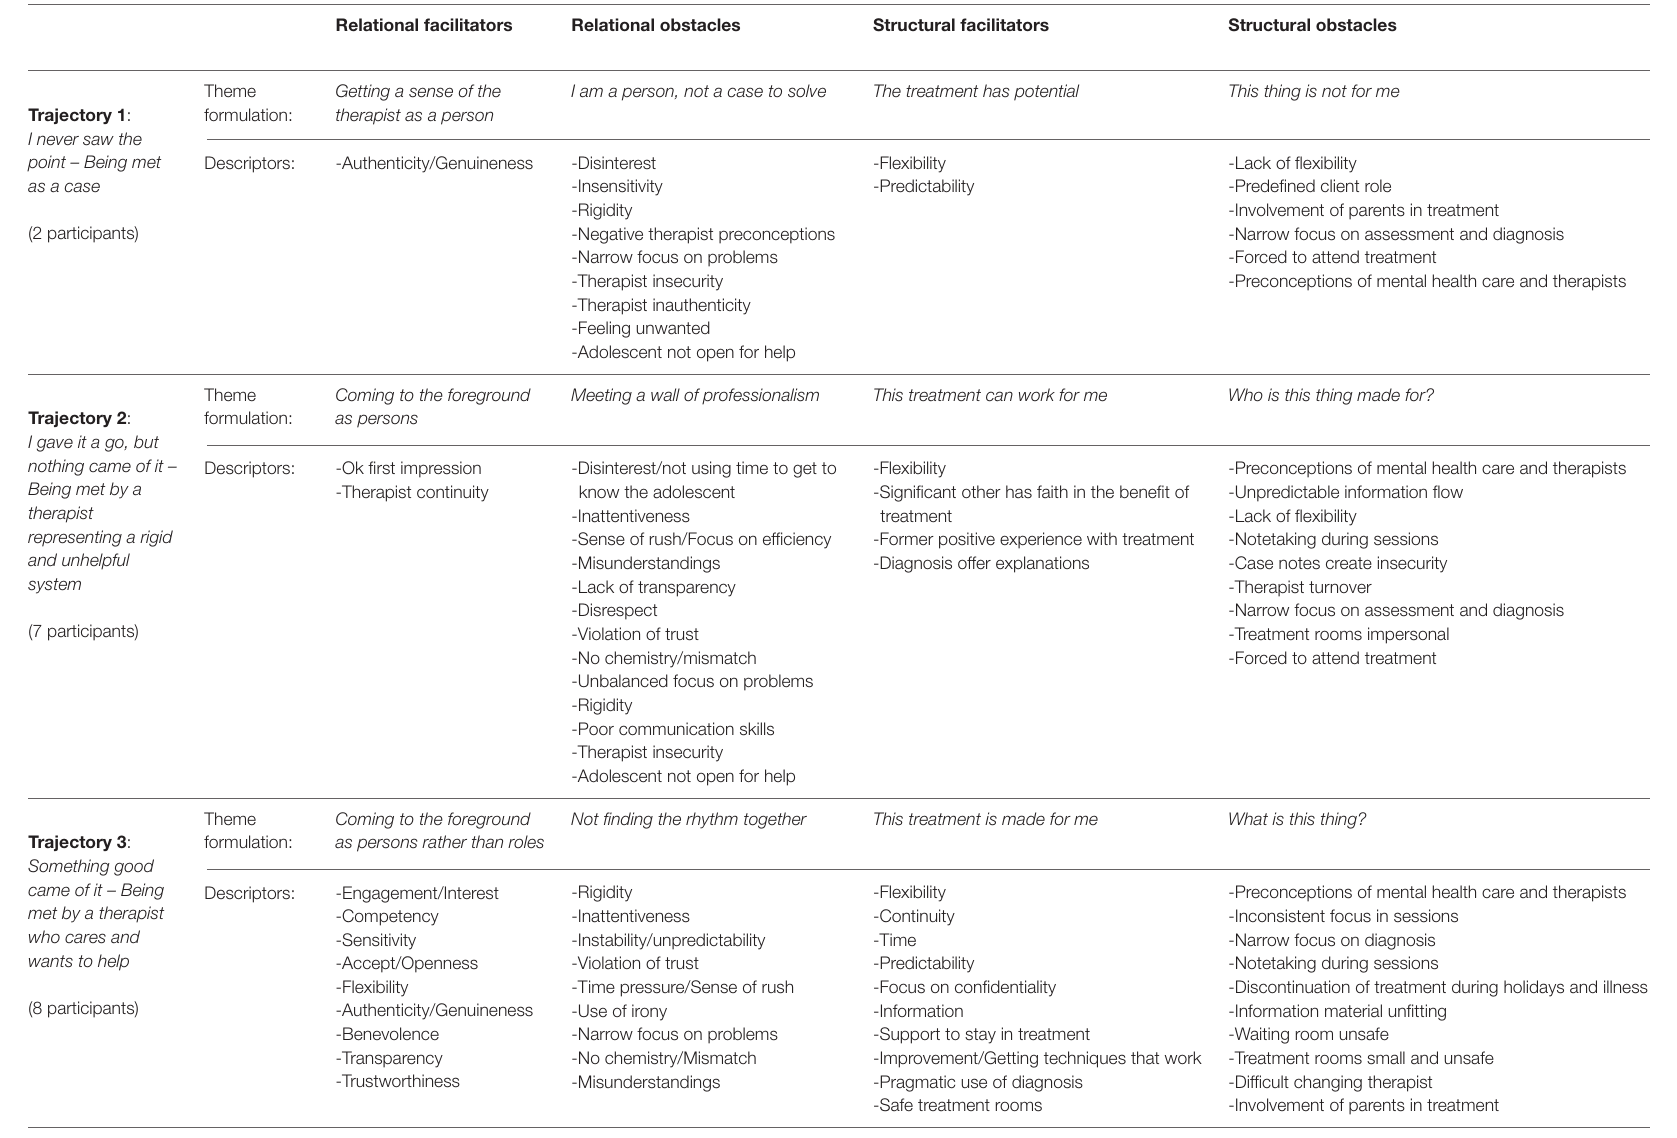
TABLE 2 | Overview of theme formulations (in italic) and descriptors within each category for the three